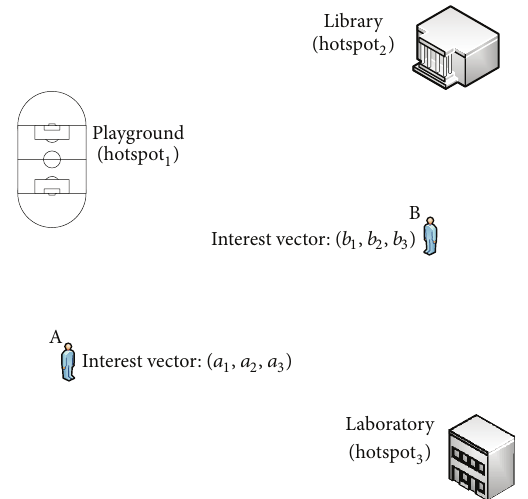
Figure 2: An IHC scenario containing three hotspots and two